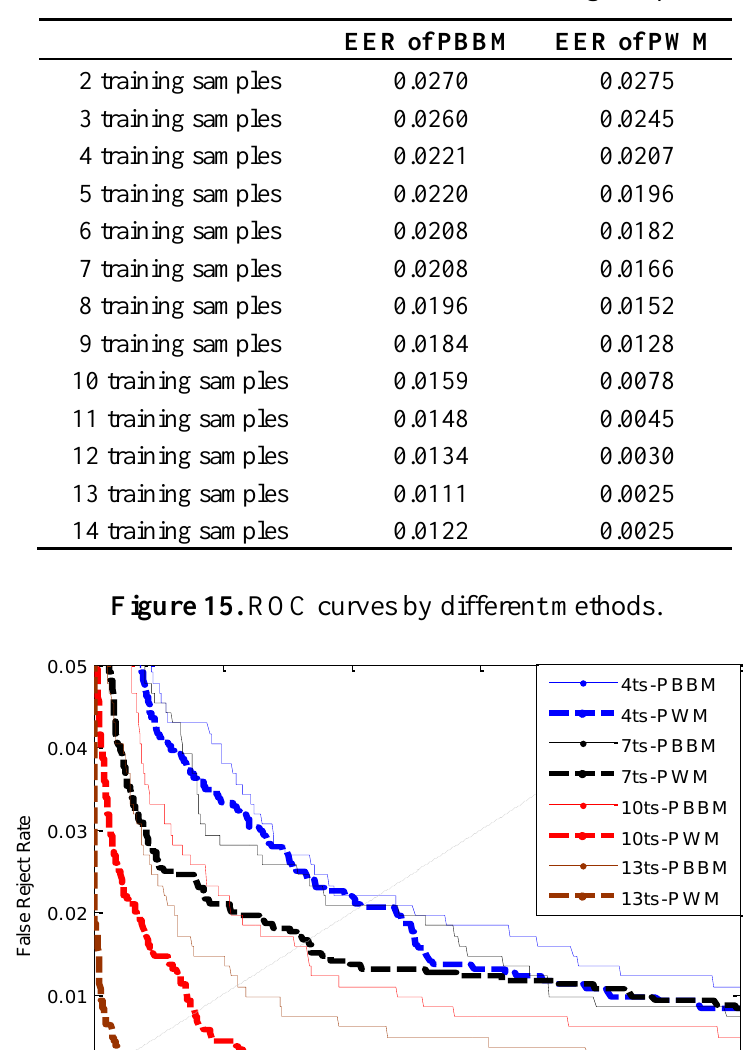
Table 8. EER contrast with different training samples.